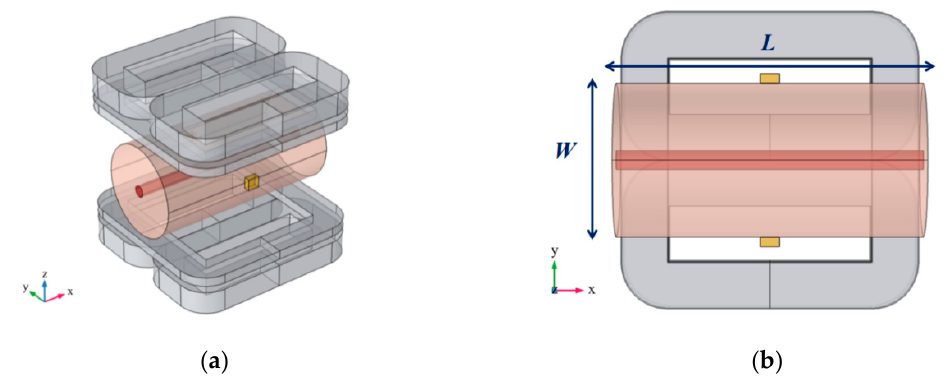
Figure 2. Schematic diagram of surface potential signal simulation measurement in an artery model. ( a ) 3-D view; ( b ) x-y view. ( a ) 3-D view; ( b ) x-y